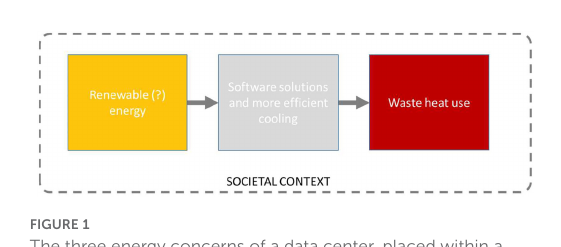
FIGURE1 The three energy concerns of a data center, placed within a societal context.